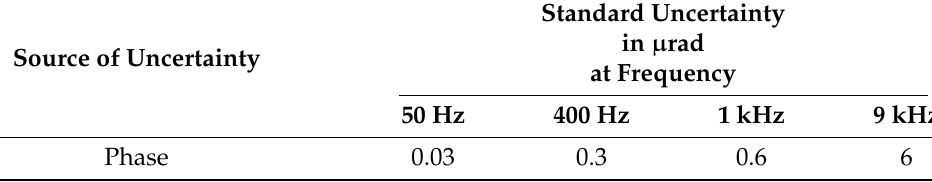
Table 2. Uncertainty of shunt